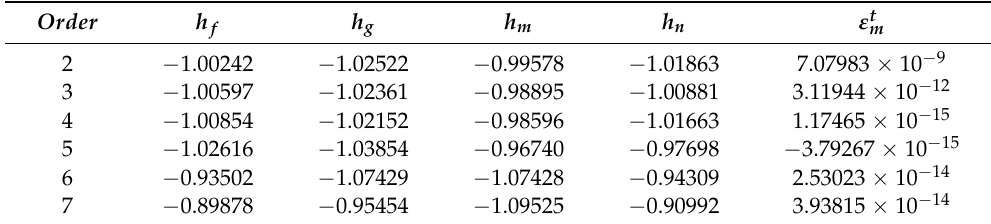
Table 2. With fixed values of S z = − 0.1, M x = 0.1, M y = 0.3, R m = 0.01, S = 1, observing the optimal values of convergence control parameters in comparison to different orders of approximation.